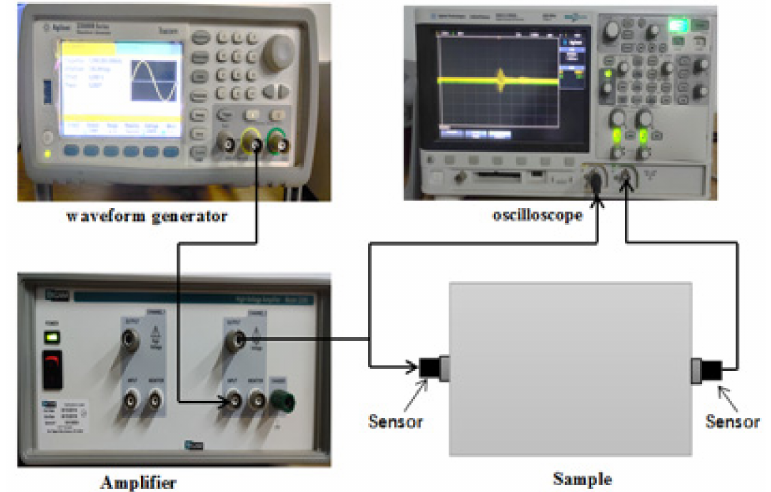
Figure 3. Diagram of guided wave testing system.